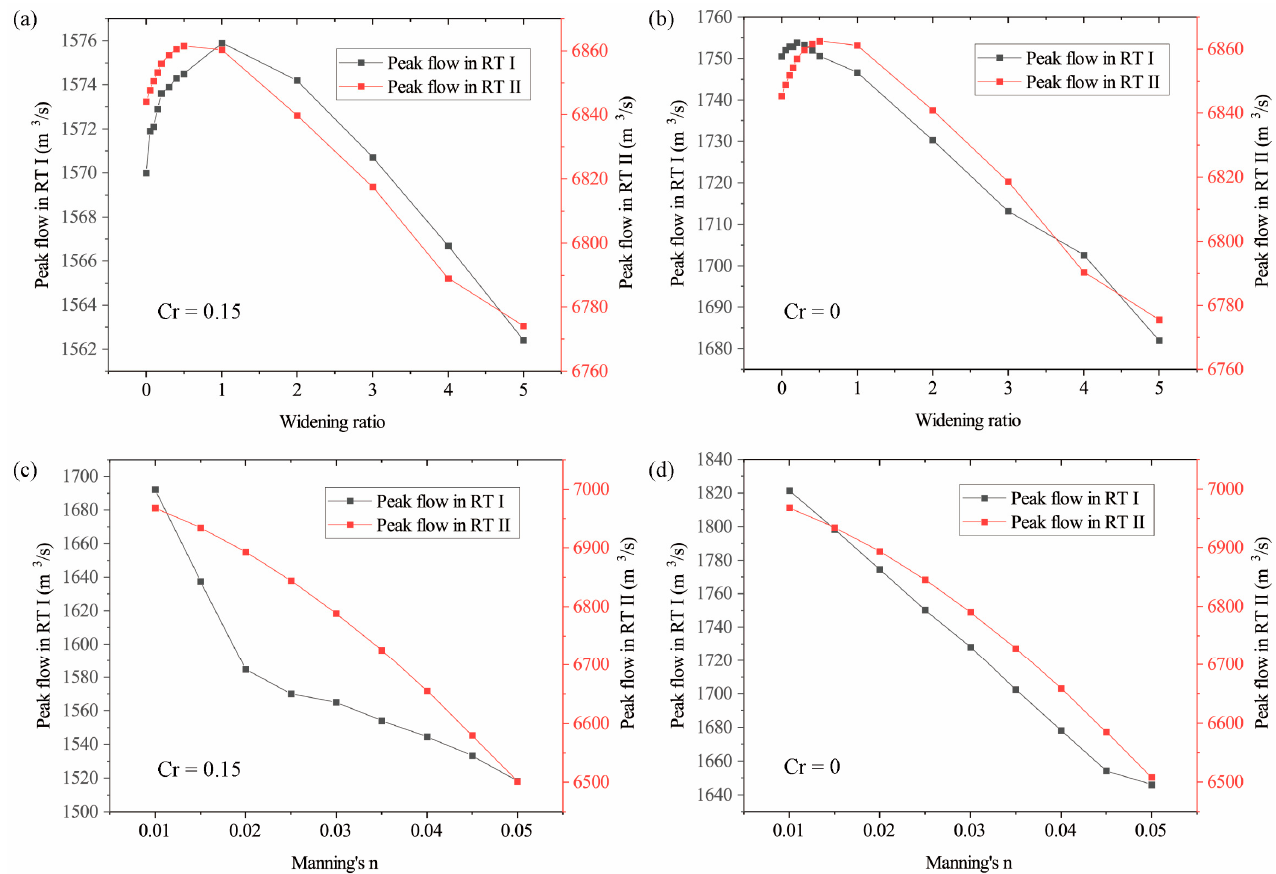
Figure 12. The relationships between flow interventions and peak flow at the control point: Widening all rivers in the watershed in equal proportion, with Cr = 0.15 (a) and Cr = 0 (b); Changing the Manning’s n of all river courses, with Cr = 0.15 (c) and Cr = 0 (d).